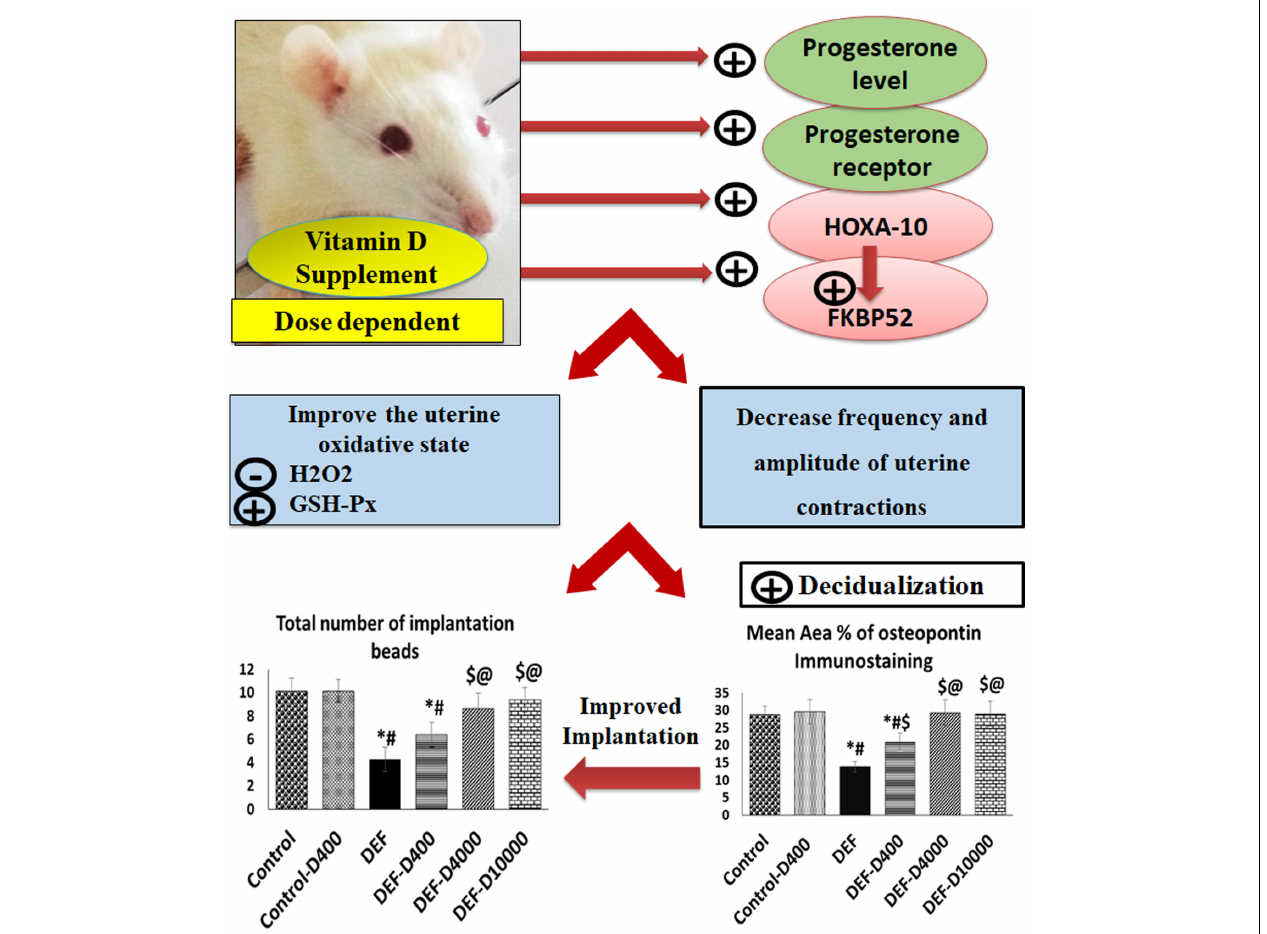
FIGURE 11 | A schematic representation demonstrating the role of VD level in early pregnancy and implantation. VD-deficient rat uteri revealed a small number of uterine implantation sites (beads). By VD supplementation and in a dose-dependent effect, enhanced progesterone secretion, uterine progesterone receptor, and its co-chaperone FKBP52 expression associated with HOXA-10 upregulation were obtained. This causes improving the oxidative stress markers; GSH-px and the H 2 O 2 levels and favors decasualization and controlled uterine contractions, thus improved uterine receptivity and promoted the implantation process. The role of VD on increased receptivity was mediated through the modulation of the immunophilin FKBP52,